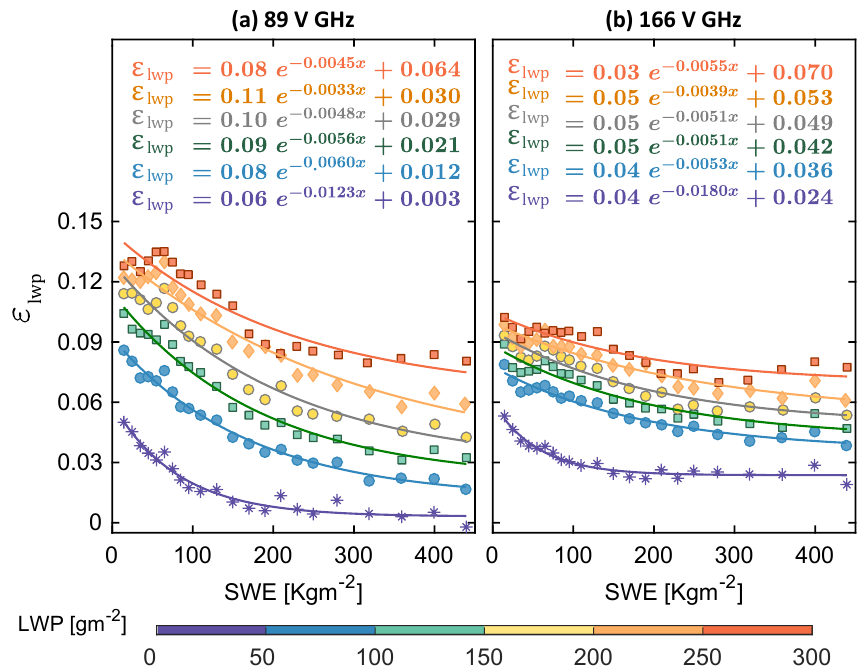
Figure 5. The atmosphere emissivity due to the cloud liquid water path ( ε lwp ) against the snow cover water equivalent (SWE) at GPM high-frequency channels 89 V GHz ( a ) and 166 V GHz ( b ). The lines represent the best fit for each LWP interval shown in the